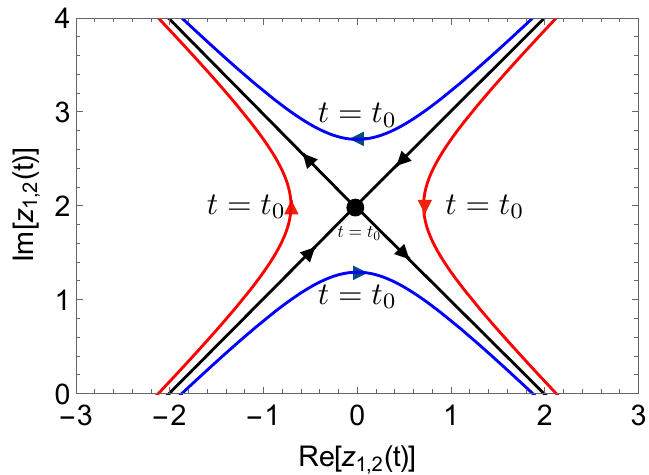
= 1, t = 0 and z = i . The three colors correspond to C = − 0.5 o 0 0